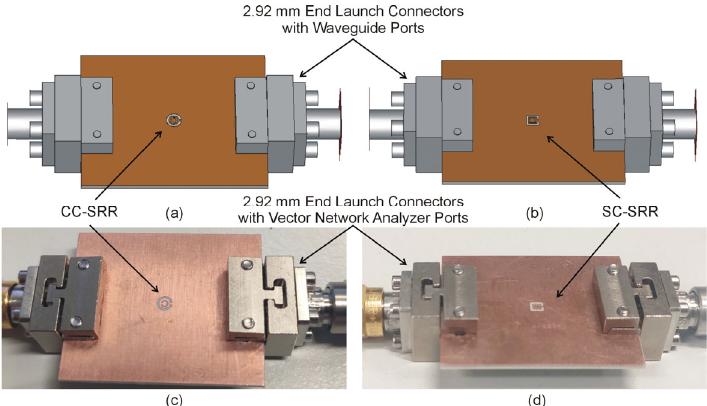
Figure 9. ( a ) Simulated model of optimized CC-SRR sensor with end launch connectors, ( b ) Simulated model of optimized SC-SRR sensor with end launch connectors, ( c ) Fabricated CC-SRR sensor with end launch connectors, and ( d ) Fabricated SC-SRR sensor with end launch connectors.